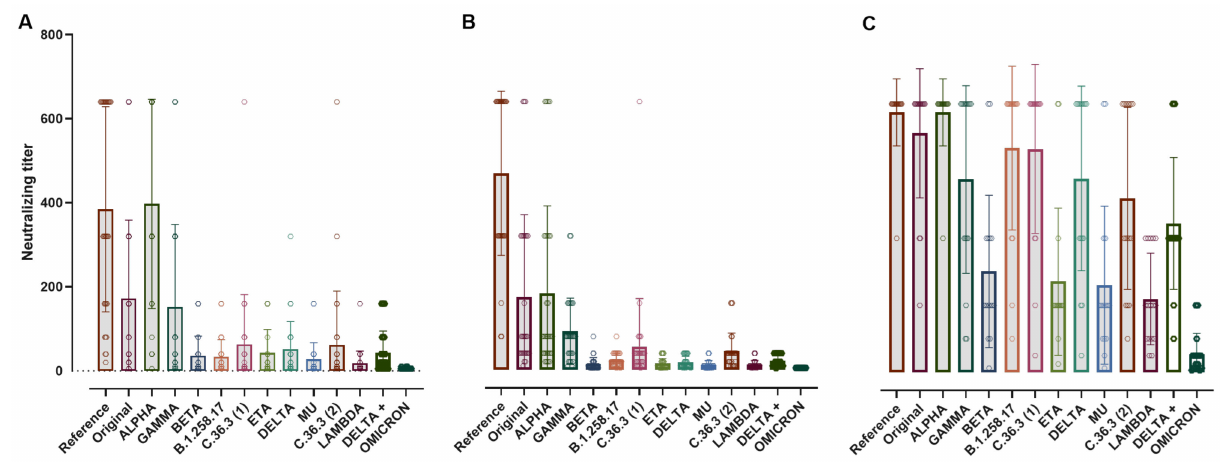
Figure 2. Scatter dot plot of the neutralizing titer for convalescent-PD ( A ), naïve-HCW ( B ) and exposed-HCW ( C ) following 2 doses of BTN162b2. In the graph, the bars stop at the titer mean for each variant. The convalescent-PD group has a high response only for the reference strain while the naïve-HCW has a high response to both the reference and alpha variants, but overall mimics the convalescent-PD trend. The experienced-HCW cohort achieved the highest response to all the different SARS-CoV-2 variants between the groups. High titers were associated with a larger variability (higher SD). Reference: D614G strain; Original: